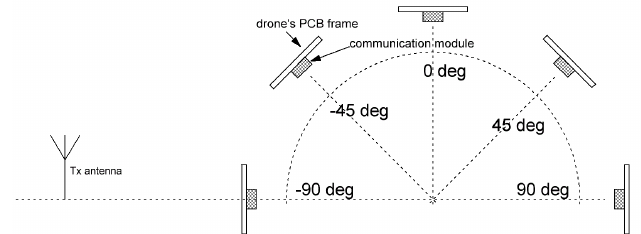
Fig. 5. Illustration of the orientation of the frame and communication module in the vertical plane.